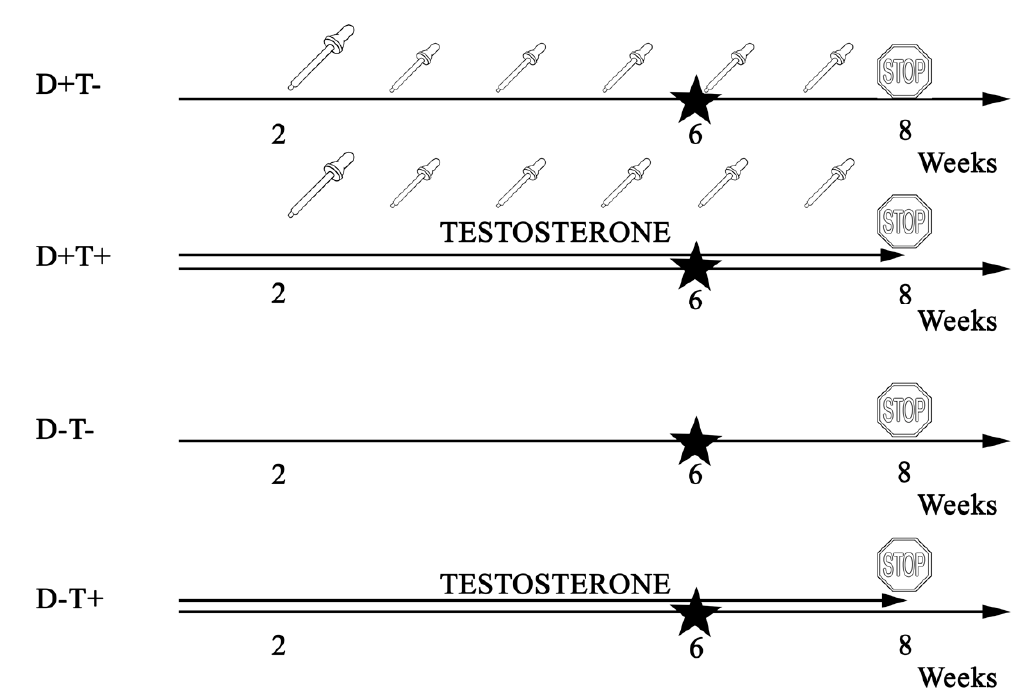
Figure 1. Timeline of chronic treatment in different treatment groups. Adolescent Wistar rats were divided into four groups—half of the animals received transdermal testosterone treatment (0.0333 mg/body weight grams 5 times weekly) for 8 weeks, while another half did not receive androgens. Half of the animals in each group were fed low vitamin D chow while the other half received adequate vitamin D supplementation (weekly 1.4 NE/body weight grams per os on the 3rd, 4th, 5th, 6th, and 7th week after a 500 NE saturation on the 2nd week). On the 6th treatment week, an oral glucose tolerance test (OGTT) was performed. On the 8th treatment week, the animals were sacrificed, and their tissues were kept at − 80 °C until further studies.